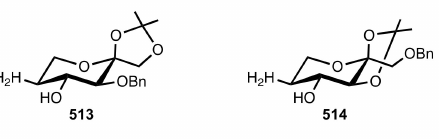
Figure 35. D -Fructose-derived organocatalysts 513 and 514 .